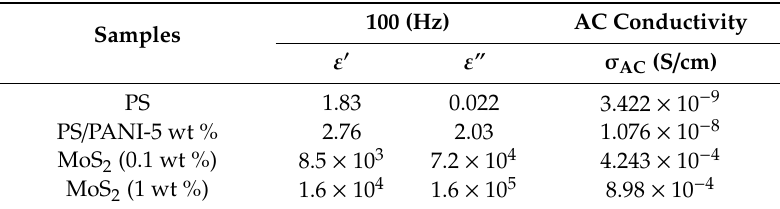
Table 1. The values of ε (cid:48) , ε ” and σ AC for PS, PANI, PS / PANI-5wt% polymer blend, PS / PANI / MoS 2 hybrid composites at 100